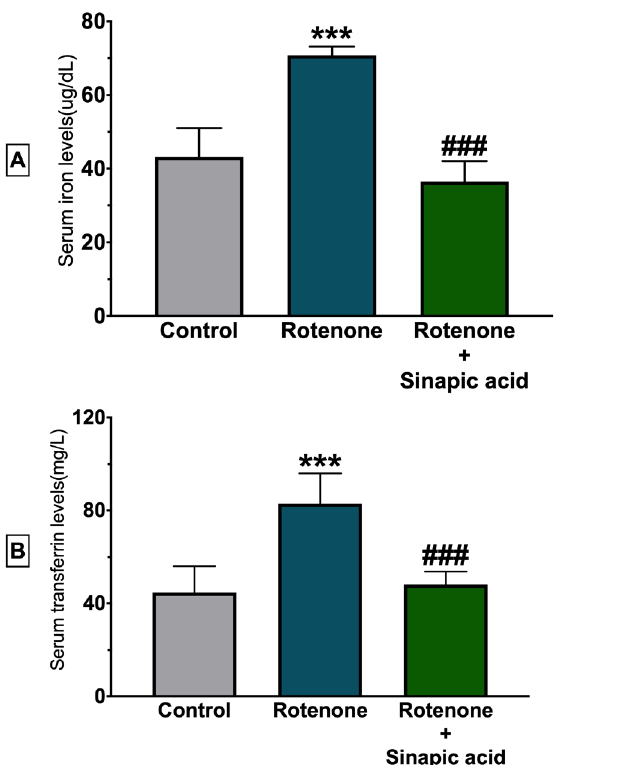
FIGURE 3 - Rotenone significantly increased serum iron and transferrin levels (B). But sinapic acid significantly prevented rotenone-induced increase in the iron and transferrin levels (n=8 for each group). All data expressed as mean ± SD. ***p<0.001 versus control group, ### p<0.001 versus rotenone